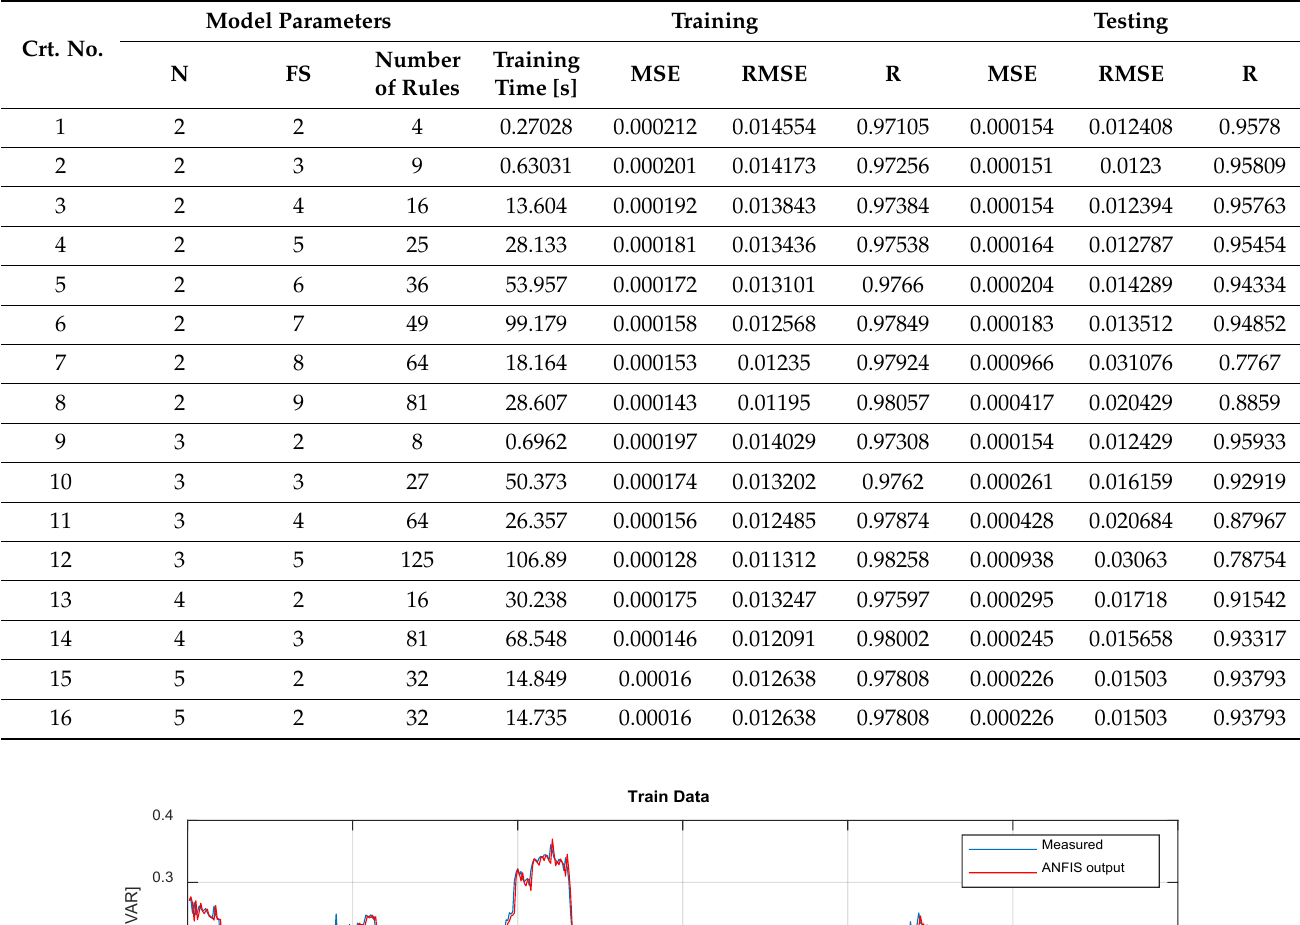
Table 1. ANFIS training performance using grid partition method.